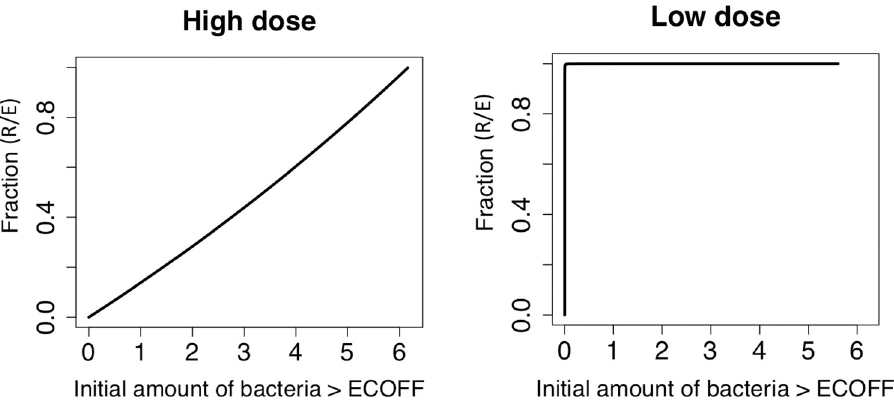
Fig 10. Varying initial bacteria. We shift only the initial condition r 0 from 0 to the total amount of E. coli in each treatment and investigate how this effects the fraction of R/E, or the proportion of E. coli about ECOFF.